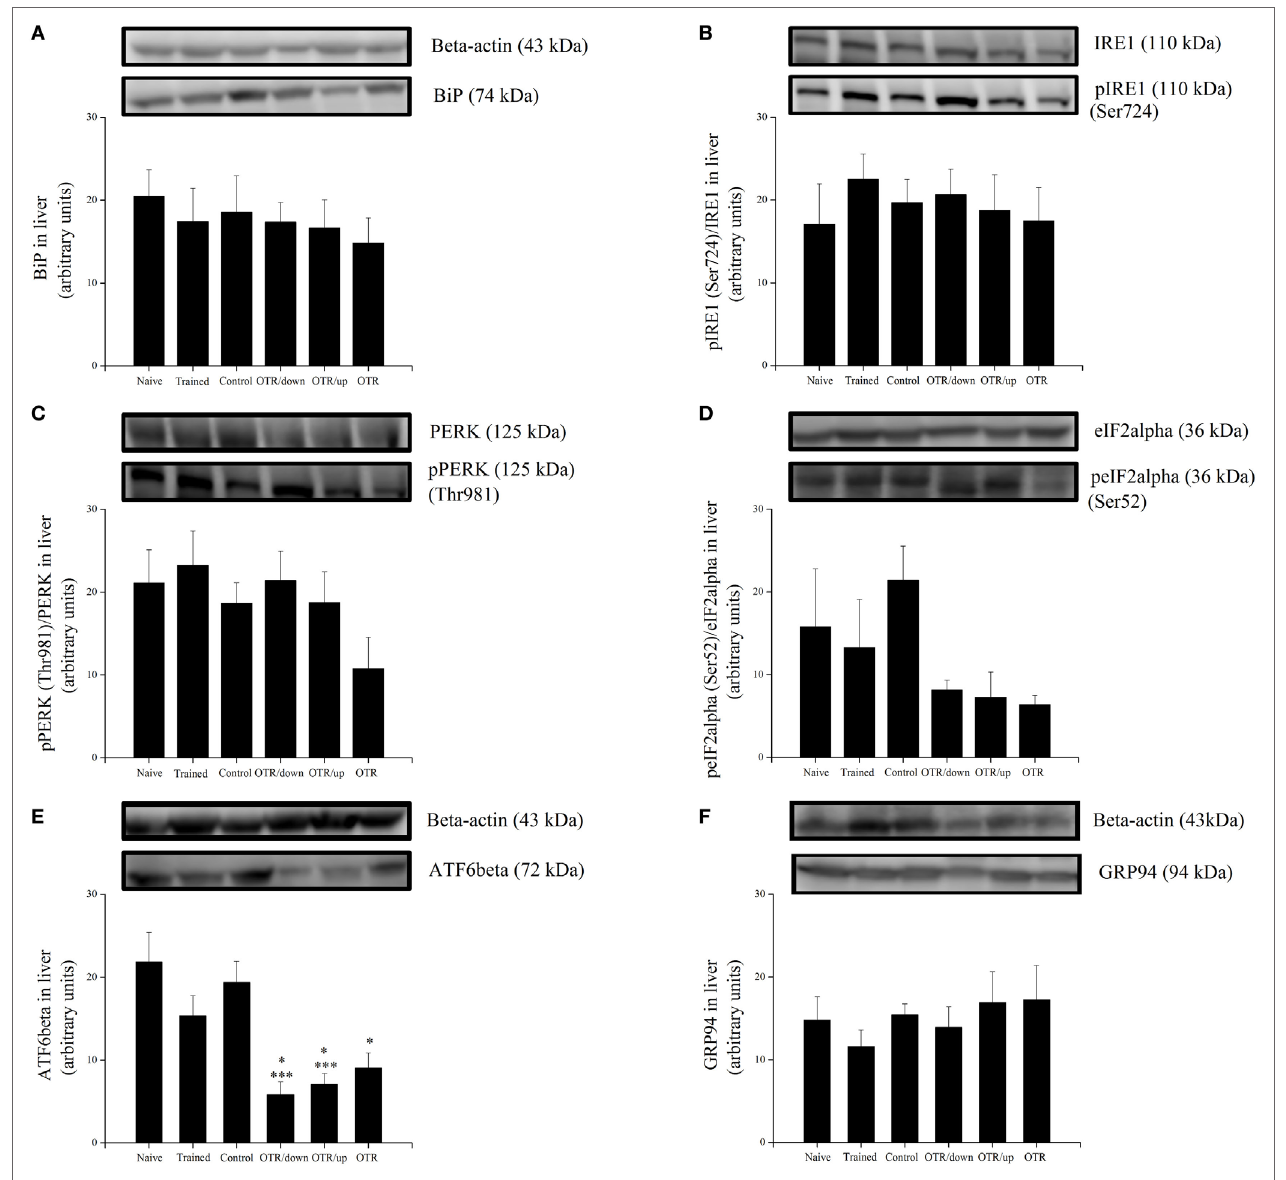
FigUre 2 | Protein levels (arbitrary units) of BiP (a) , pIRE1 (Ser724)/inositol-requiring enzyme 1 (IRE1) (b) , pPERK (Thr981)/protein kinase RNA-like endoplasmic reticulum kinase (PERK) (c) , peIF2alpha (Ser52)/eIF2alpha (D) , ATF6beta (e) , and glucose-regulated protein 94 (GRP94) (F) in the livers of experimental animals. Data are expressed as the mean ± SE of n = 6 mice. N, sedentary mice; TR, trained mice; CT, sedentary mice; OTR/down, overtrained by downhill running; OTR/ up, overtrained by uphill running; OTR, overtrained by running without inclination. * P < 0.05 vs. CT group. *** P < 0.05 vs. N group. The original experiments are available in supplementary file 1 (i.e., BiP, peIF2alpha, eIF2alpha, and ATF6beta), file 2 (i.e., pIRE1, IRE1, Pperk, and PERK), and file 3 (i.e.,